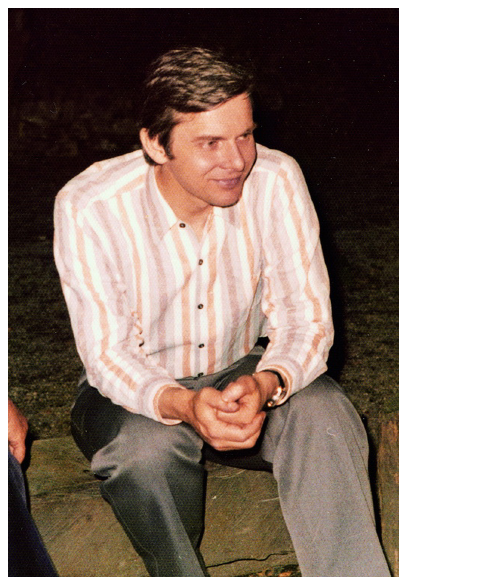
Figure 3. Prof. Dr Hansjochem Autrum chaired the DFG Senate Commission (picture from S. Autrum-Mulzer).